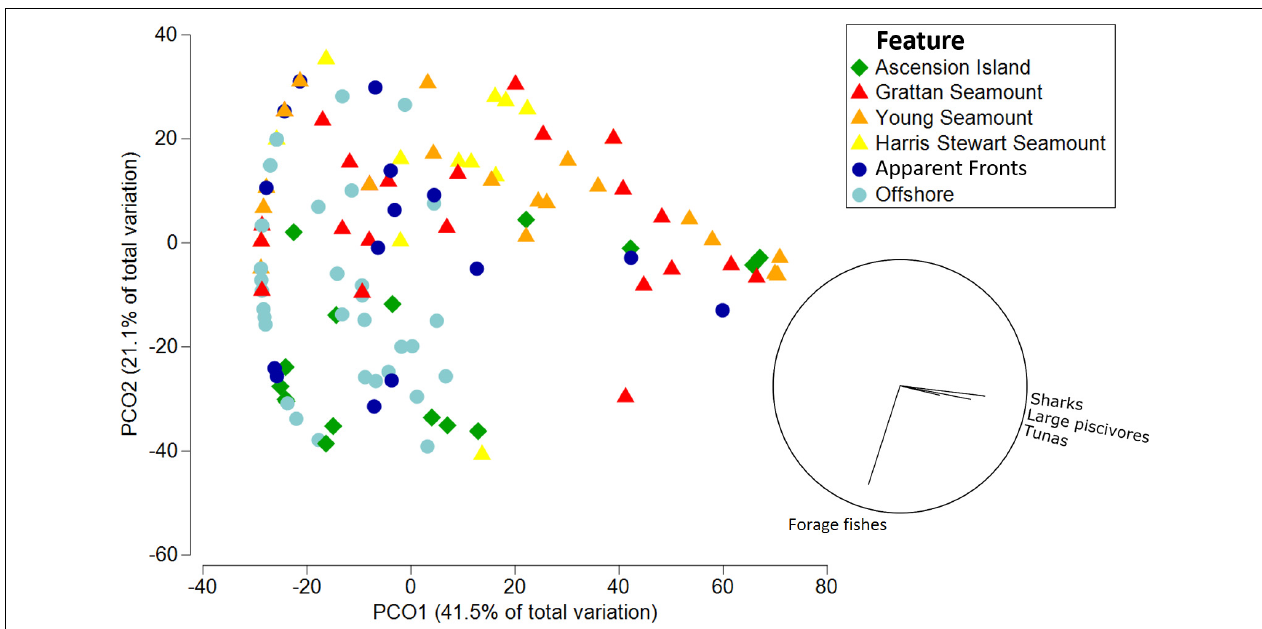
FIGURE 4 | Principal Components Analysis of total abundance of pelagic wildlife by functional groups. Symbols indicate the feature of the sample site, vector plot indicates functional groups with a correlation greater than